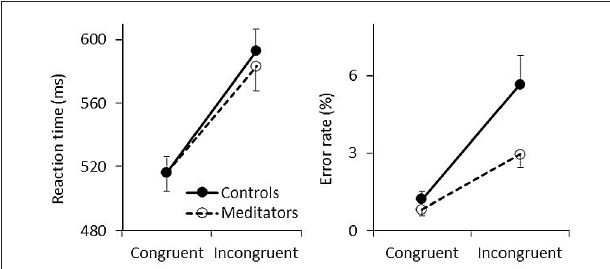
FIGURE 2 | Behavioral results. Mean reaction time (RTs; left) and error rates (ERs; right) are shown for congruent and incongruent trials. Solid and dashed lines represent controls and meditators, respectively. Error bars represent standard errors of the means.